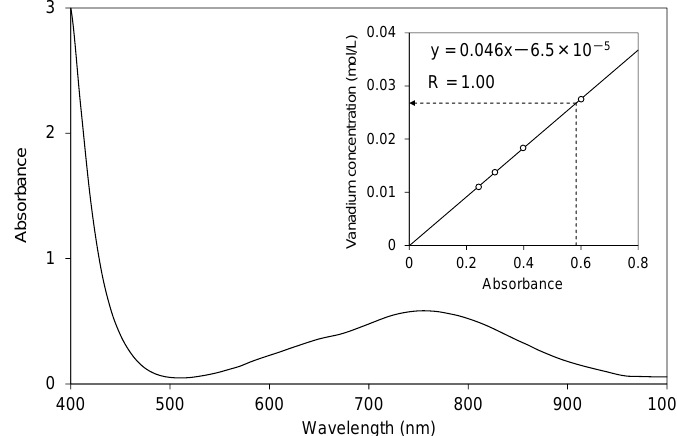
Figure 2. Energy-dispersive X-ray spectroscopy (EDS) spectra of the slag ( a ) and the precipitates obtained in the subsequent extraction steps in Scheme 1; ( b ) Residue after extraction at Step 1; ( c ) Precipitate A; ( d ) Precipitate B; and ( e ) Precipitate C (see Scheme 1).